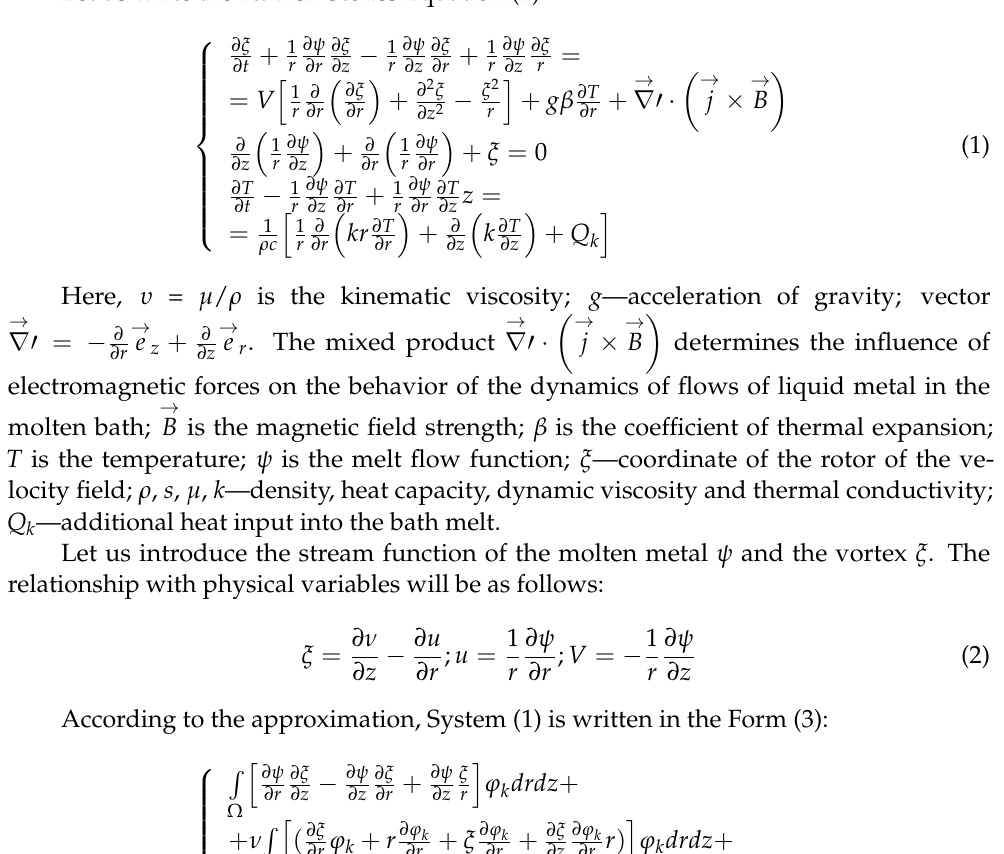
Figure 6. Scheme of approximation of a fragment of a welded joint (see Figure 4). Ω 1 —base metal area; Ω 2 —area of the molten metal of the bath; Ω 3 —free surface of the bath melt. The solution was carried out in a cylindrical coordinate system in an axisymmetric setting. It was assumed that a quasi-stationary process of heat transfer and crystallization takes place.